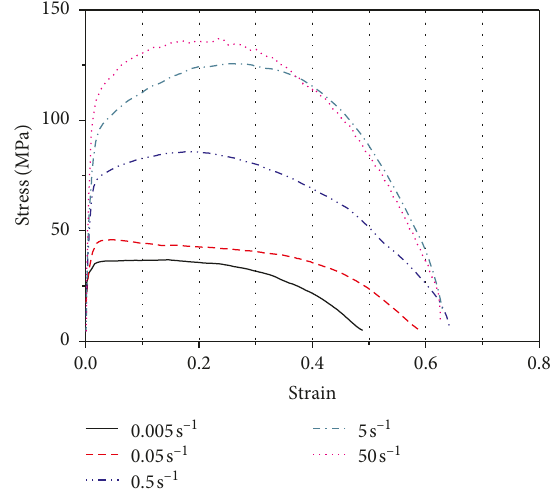
Figure 2: Tensile flow curves of 2205 DSS.